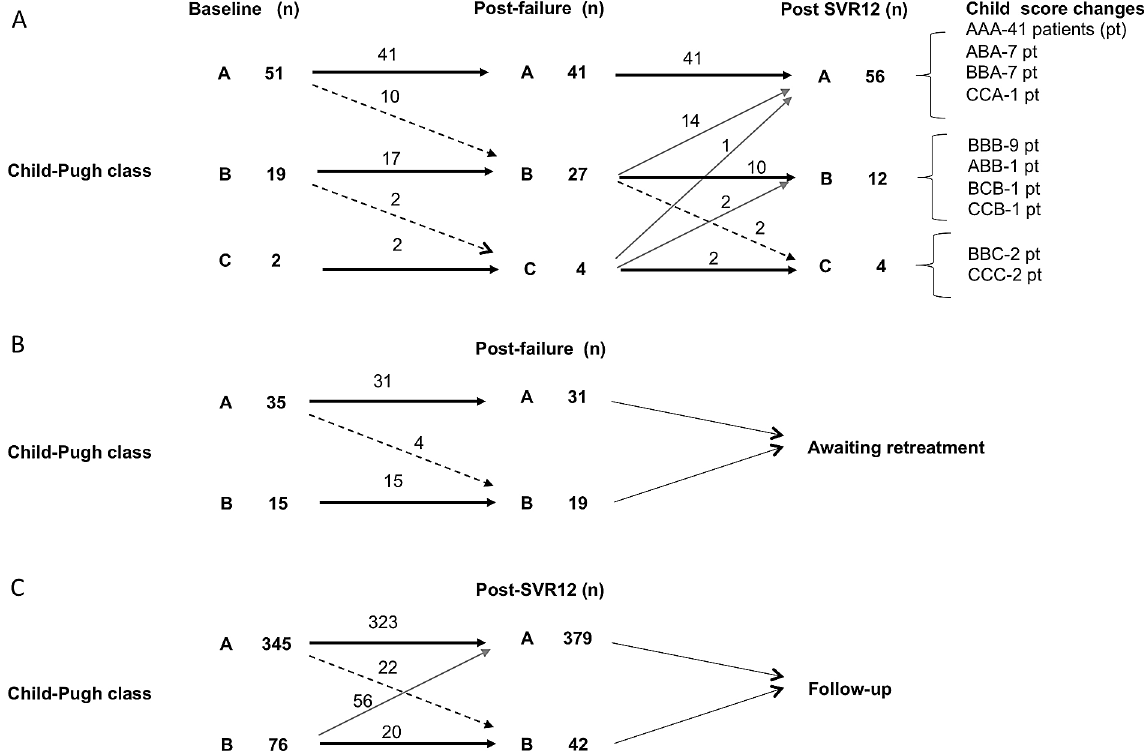
Fig 1. Modifications of liver disease stage following DAA treatment in patients with cirrhosis. (A) Baseline,post-failure and post-retreatment SVR12 changesof Child Pugh Class; (B) baselineand post-failurechangesof ChildPugh Class for patients who were not retreated yet; (C) baselineand post-SVR12 changesof ChildPugh Class for patients who achievedSVR12 followingthe first DAA treatment. Bold arrows indicatepatients who did not changethe Child Pugh Class. Dashedarrows indicate patients who worsenedthe ChildPugh Class, whereasthe grey arrows indicatepatients who improvedthe ChildPugh class. In the curly brackets are reportedthe number of patients for specific changes observedin the ChildPugh classes in the three points of evaluation. n = number of